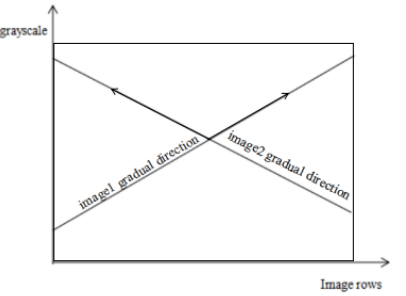
Figure.5 noise reduction in the different direction